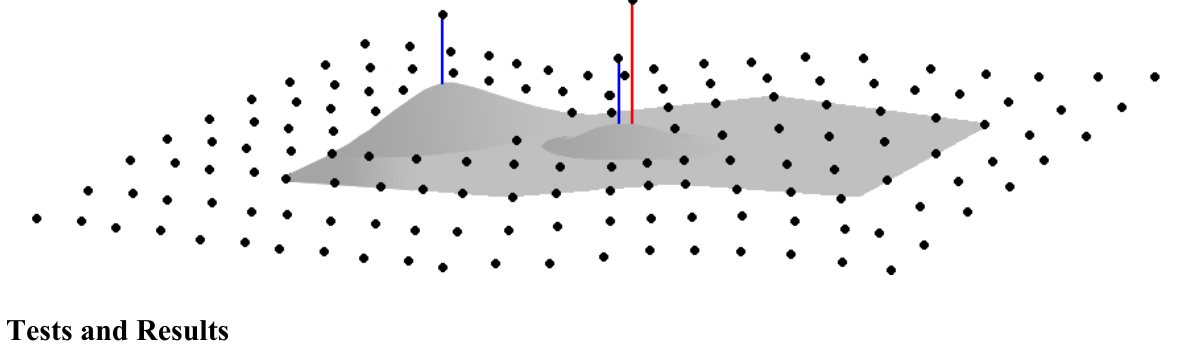
Figure 5. Polynomial surface patch generated using a data section containing outlying points. Blue lines indicate outliers used to compute the surface. The Red line indicates the point being tested as an outlier.